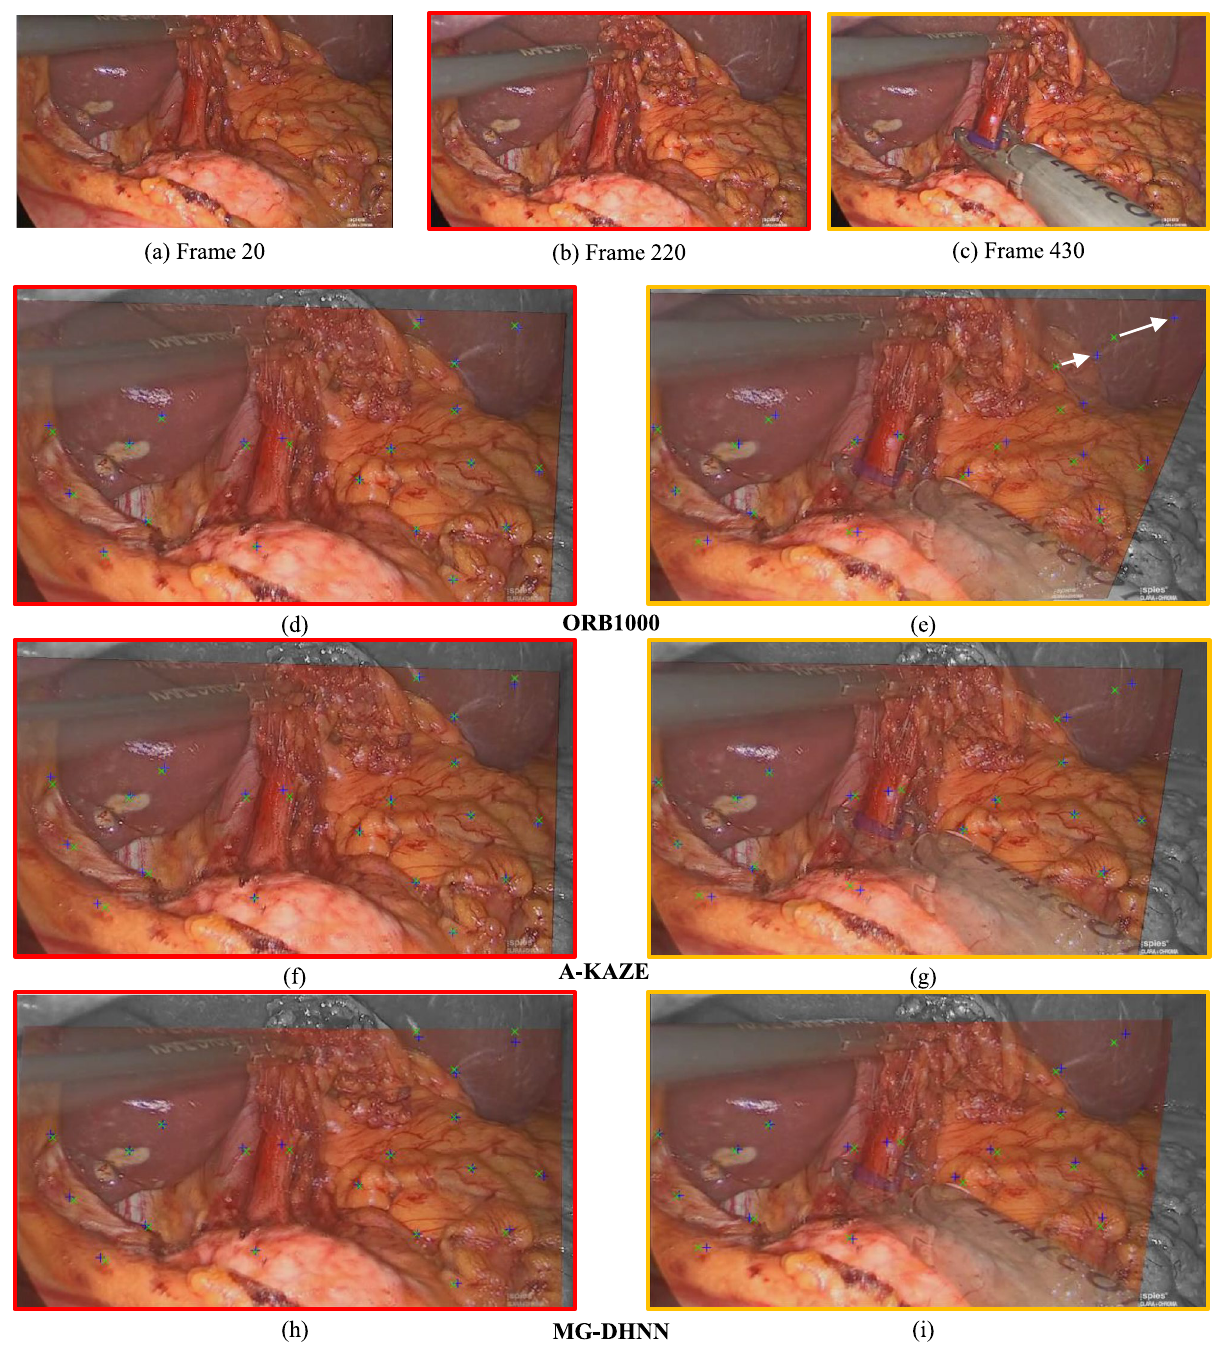
Figure 4. Image registration results with the single homography method. ( a ) Frame 20 is used as the start frame of scene 1. ( b ) Frame 220 with small perspective changes, instrument movement, and organ deformation in relation to frame 20. ( c ) Frame 430 shows occlusions from an instrument and organ deformation due to manipulation compared with frame 20. ( d )–( i ) Semitransparent overlay of the transformed start frame 20 and the current frames 220 (left column, red) and 430 (right column, yellow) for ORB1000 ( d , e ), A-KAZE ( f , g ), and MG-DHNN ( h , i ). Green crosses indicate the ground truth and blue crosses the estimated position of the annotated points. White arrows highlight large registration errors and non-overlapping regions are shown in greyscale. The normalized RE averaged over the annotations of the shown frame are 0.1 for d , f , and g ; 0.26 for e ; 0.13 for h and i